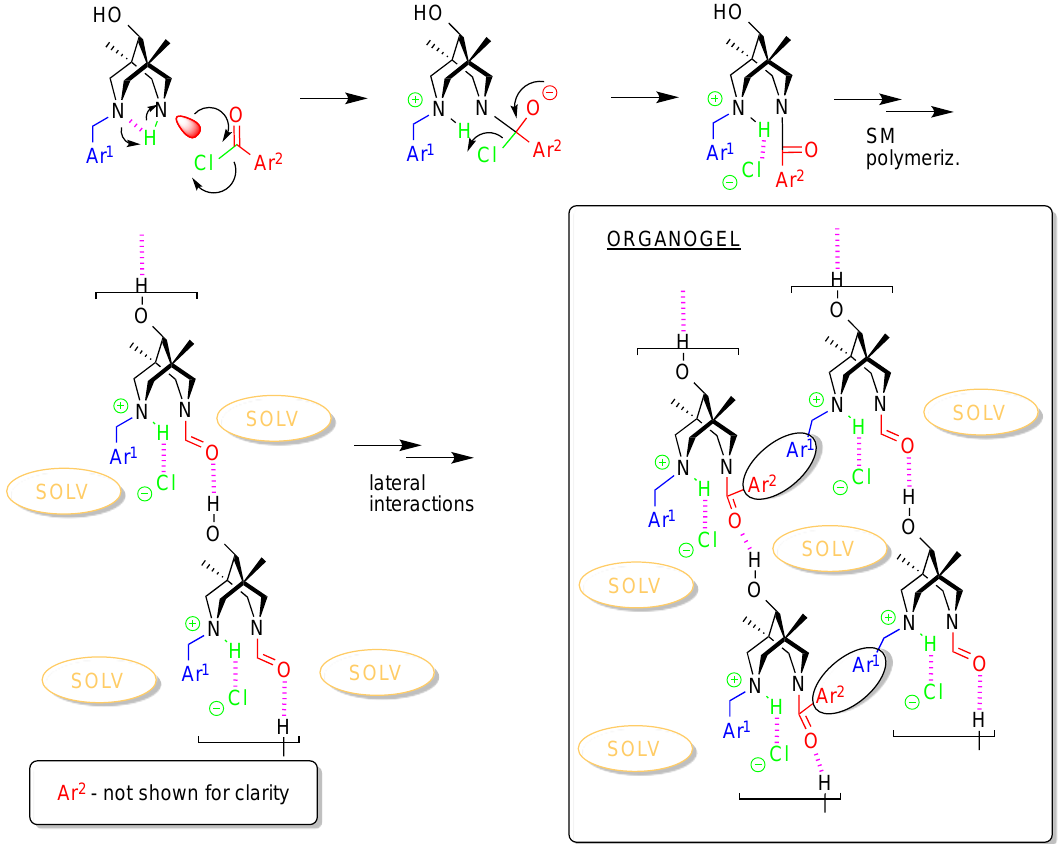
Scheme 3. Schematic representation of a possible method of gel formation.